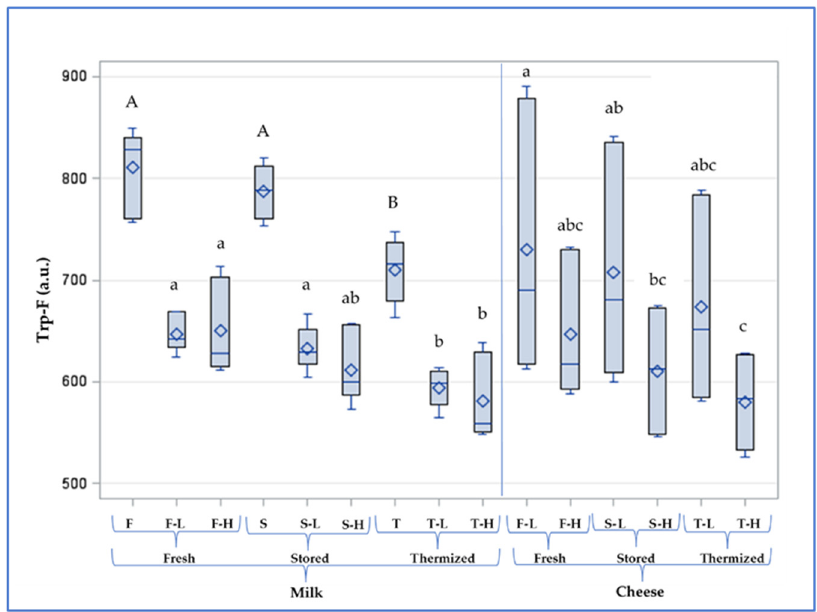
Figure 4. Comparison of Trp-F (Tryptophan fluorescence) in milk before pasteurization and after low and high pasteurization, and in the corresponding cheese made from each type of milk. Different letters indicate significant differences ( p < 0.05) within the group of milk or cheese. In the milk group, capital letters were used for milk before pasteurization (F, S and T) while lowercase letters for milk after pasteurization (F-L, F-H, S-L, S-H, T-L, T-H). Milk before pasteurization: F = fresh milk, S = stored milk, T = thermized milk. Milk after pasteurization: L = low pasteurization (72 °C for 15 s), H = high pasteurization (77 °C for 15 s).